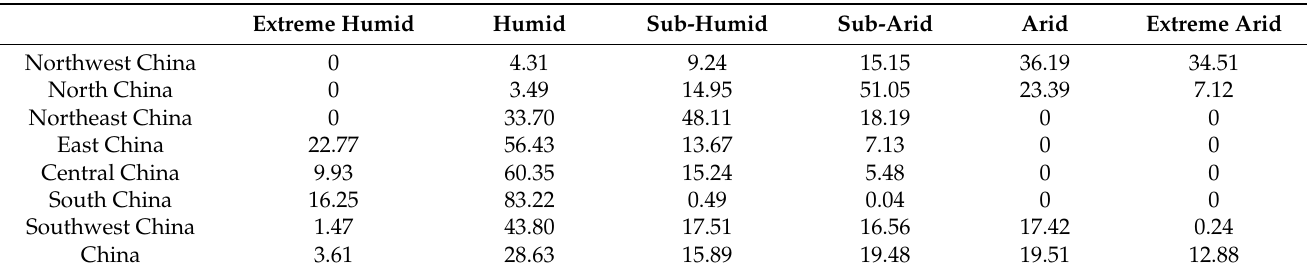
Table 4. The proportions of the area of different climate zones to the whole area of China in different regions from 1981 to 2010 (unit: %).